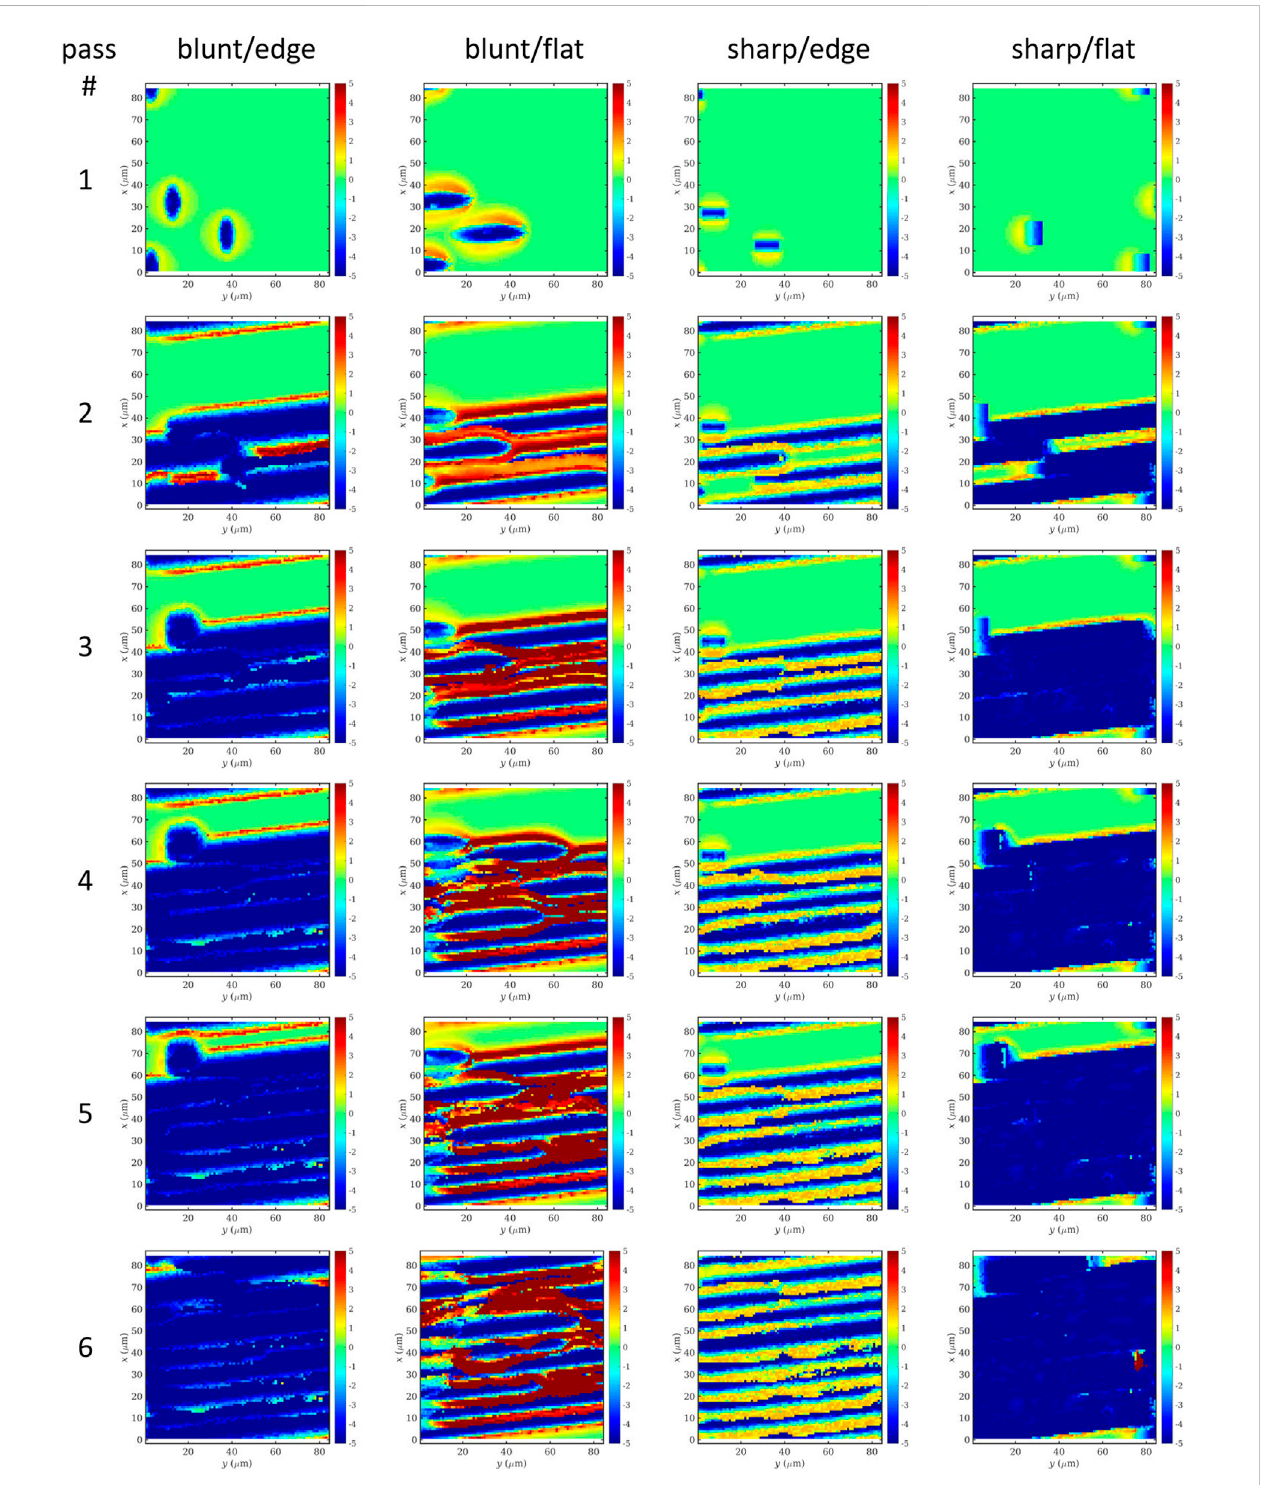
FIGURE 7 Surface topography of an MPM work piece ground with blunt or sharp abrasives in two con fi gurations each (edge and fl at) after several passes using pseudo-periodic boundary conditions.